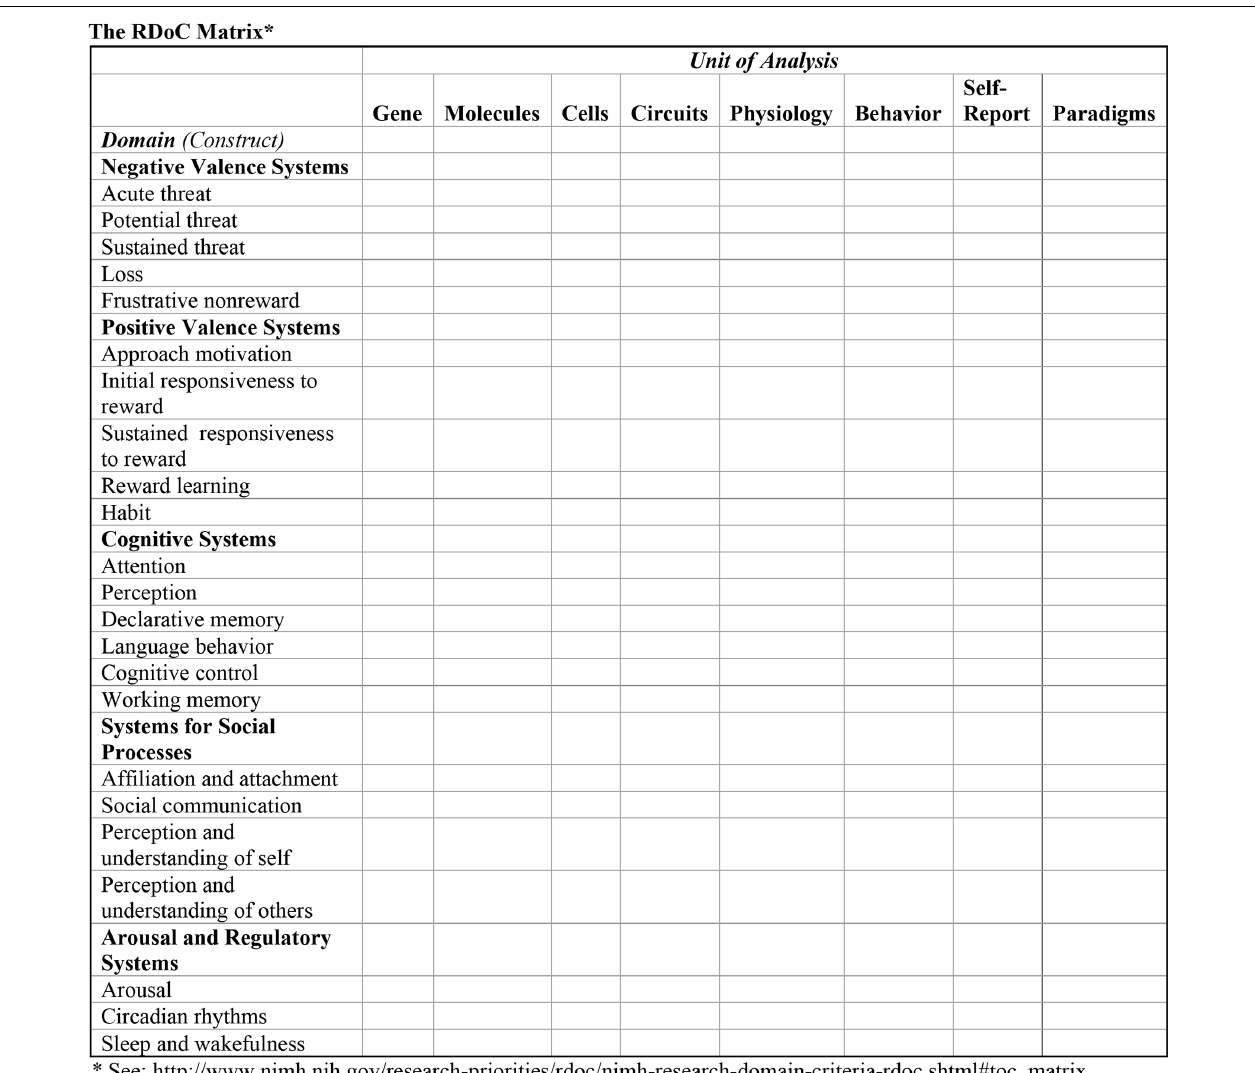
psychopathology can be traced to underlying circuitry which, in turn, can be analyzed in terms of cellular, molecular, and genetic mechanisms. Rows may be further subdivided in terms of specific constructs. A column is reserved for experimental paradigms, which may be specific to